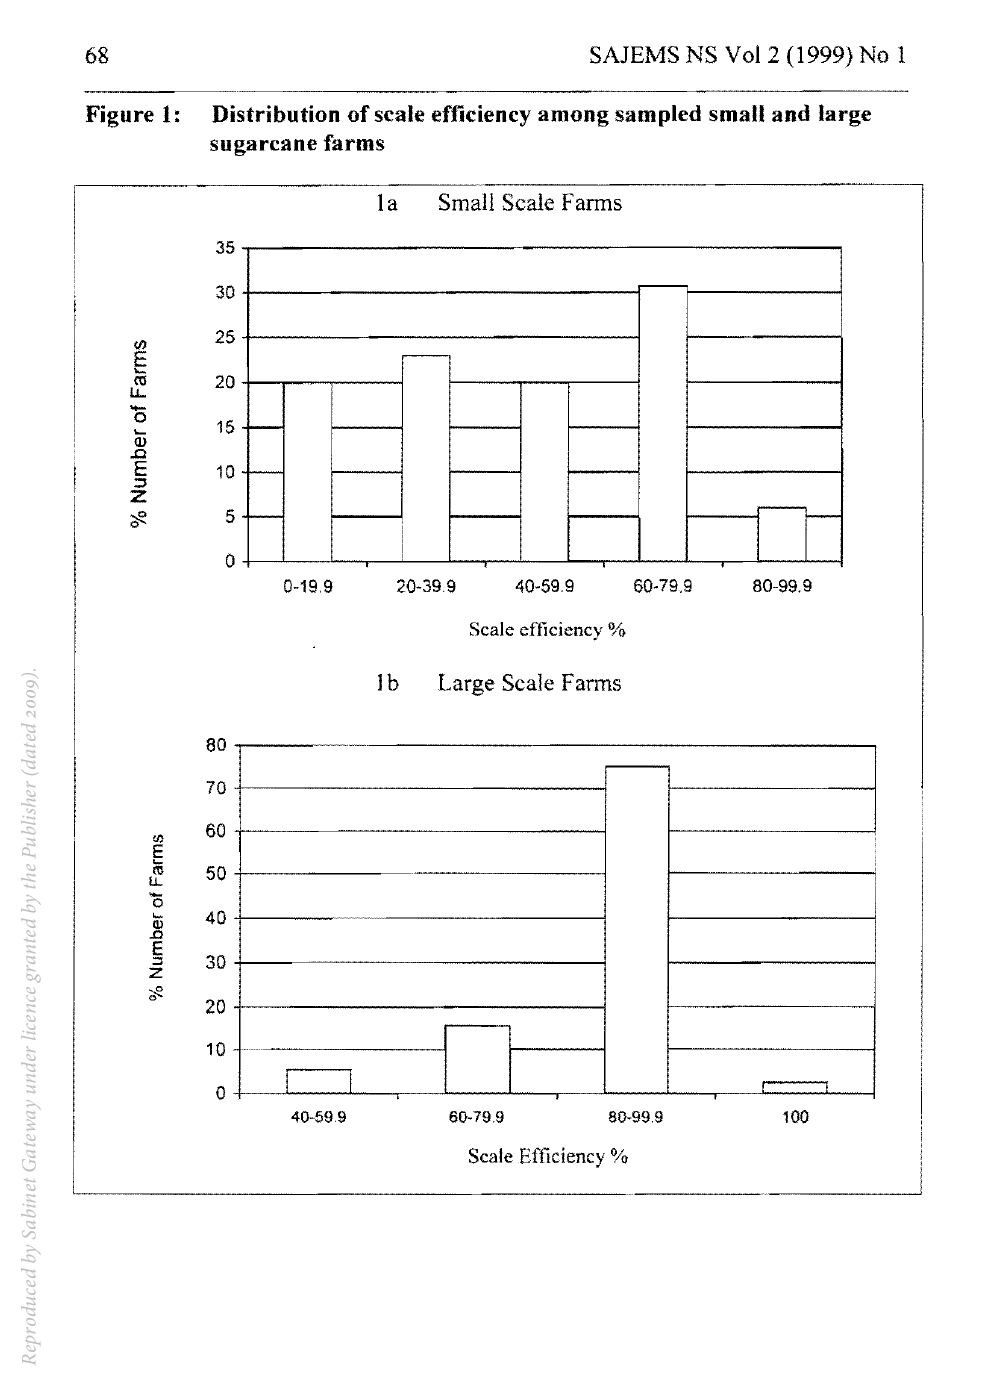
Figure 1: Distribution of scale efficiency among sampled small and large sugarcane farms 1 a Small Scale